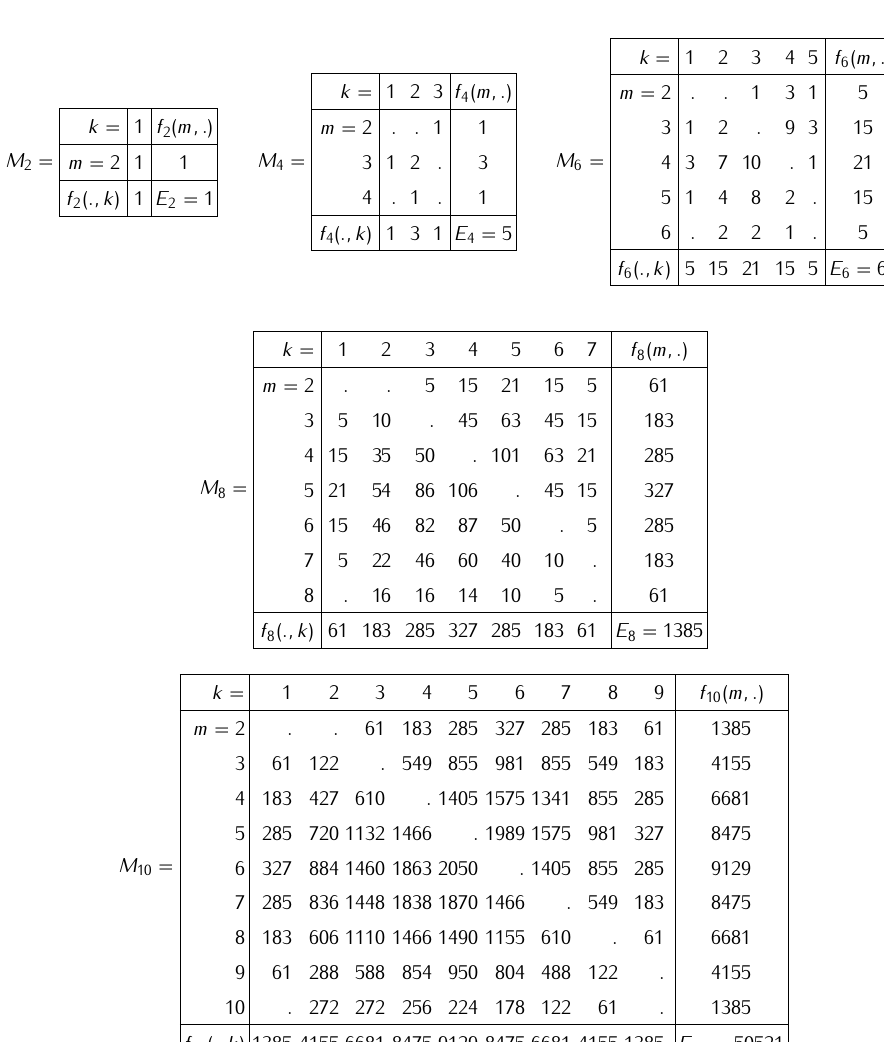
Table 1. The matrices M